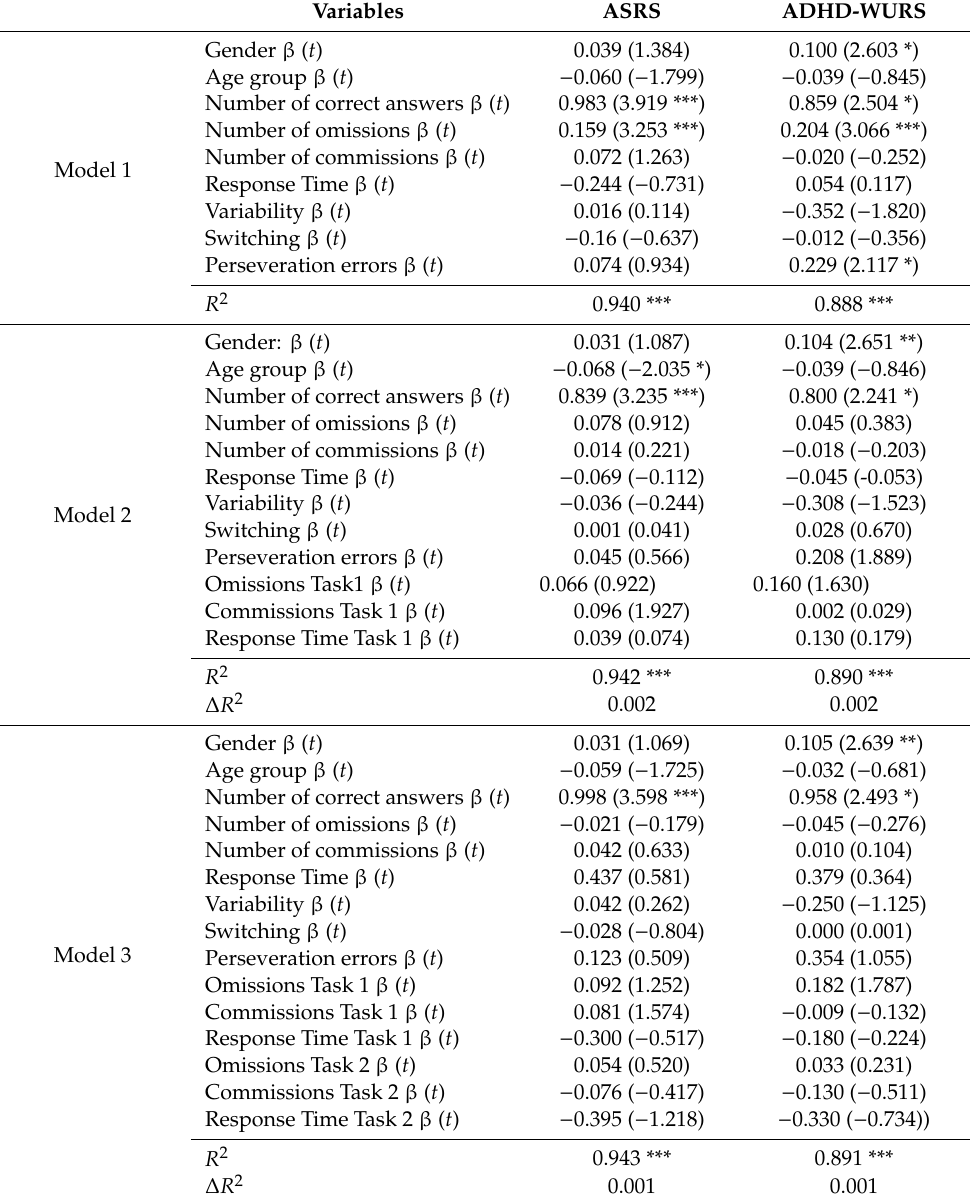
Table 2. Hierarchical regression analysis models to predict ADHD symptoms at present (ASRS) and retrospectively